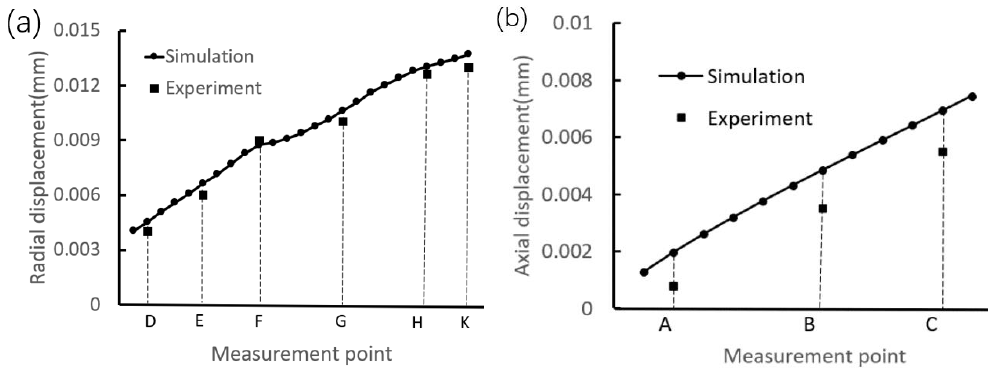
Figure 12. Displacement contour plots of the inner ring. ( a ) Radial displacement. ( b ) Axial displacement.